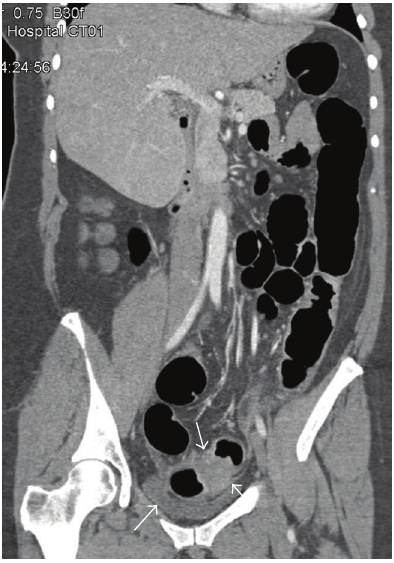
hormones, endometriosis is rare in pre- and postmenopausal women, but there are reports of it [9]. When looking at woman undergoing major gynecologic surgery for various reasons, 1% was found to have endometriosis. When looking at women who undergoes laparoscopy for chronic pelvic pain, the frequency increases to 12–32%